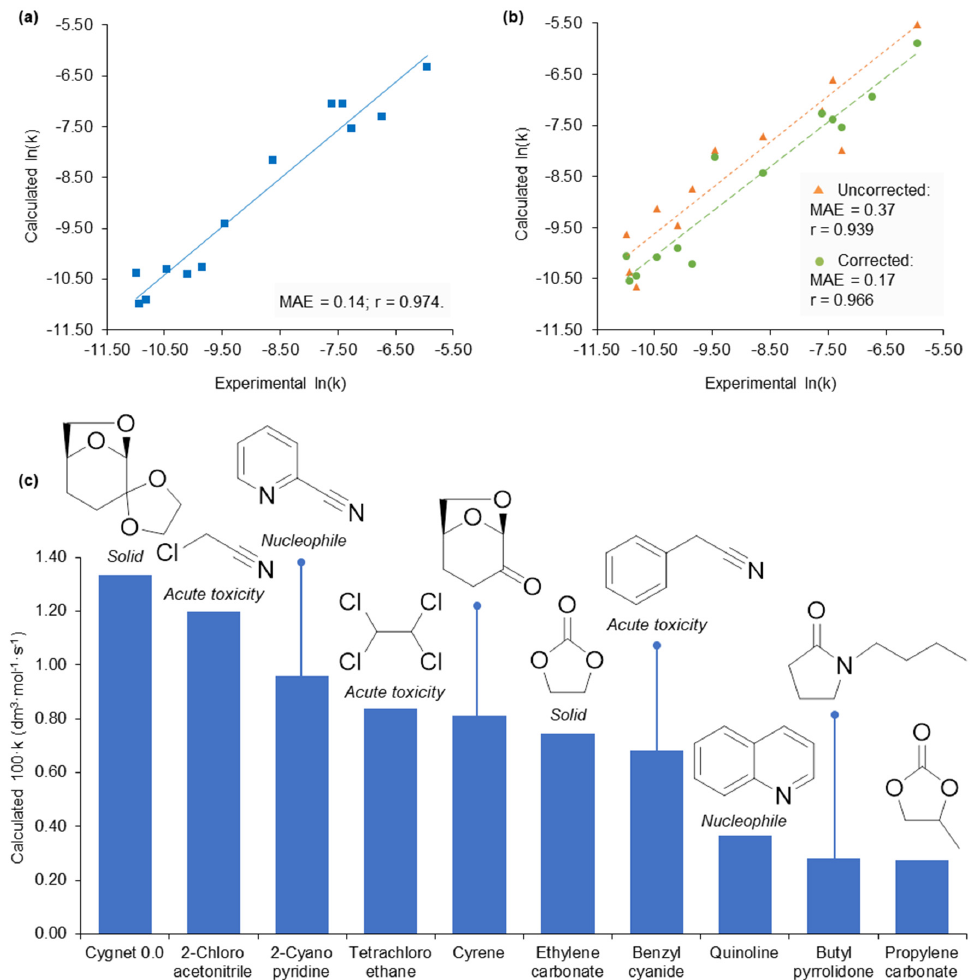
Figure 5. A demonstration of solvent selection for a Menschutkin reaction. ( a ) Comparison of experimental ln(k) and calculated ln(k) values (based on Equation (3) solved with experimental KAT parameters). ( b )SubstitutionwithcalculatedKATparametersforthepredictionofln(k)andcomparedto experimentaldata. ( c )Thetensolventswiththehighestpredictedrateconstants, annotatedwithpractical issues and molecular schemes. Cygnet 0.0 is spiro-6,8-dioxabicyclo[3.2.1]octane-4,2 (cid:48) -[1,3]dioxolane [35], and Cyrene ™ is dihydrolevoglucosenone